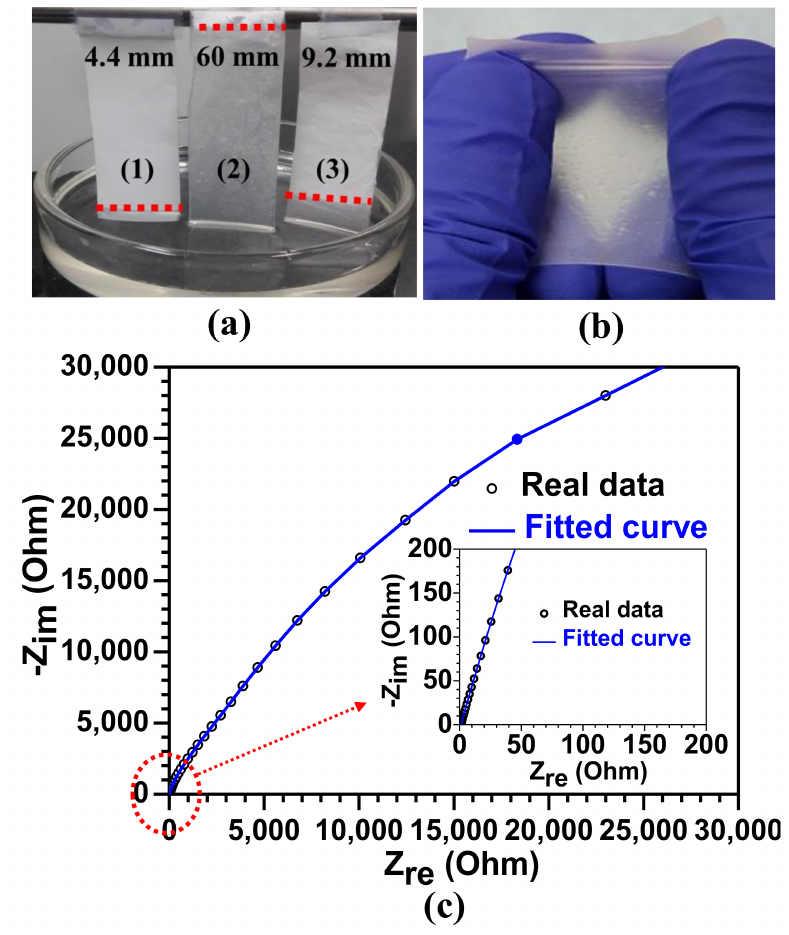
Figure 3. ( a ) Comparative investigation on the absorbed levels of liquid electrolyte into (1) commercially available polypropylene (PP) separator and as-electrospun cross-linked PVDF- co -HFP separators with the two different thicknesses of (2) 40 µ m and (3) 100 µ m for 10 s, ( b ) a photo image representing